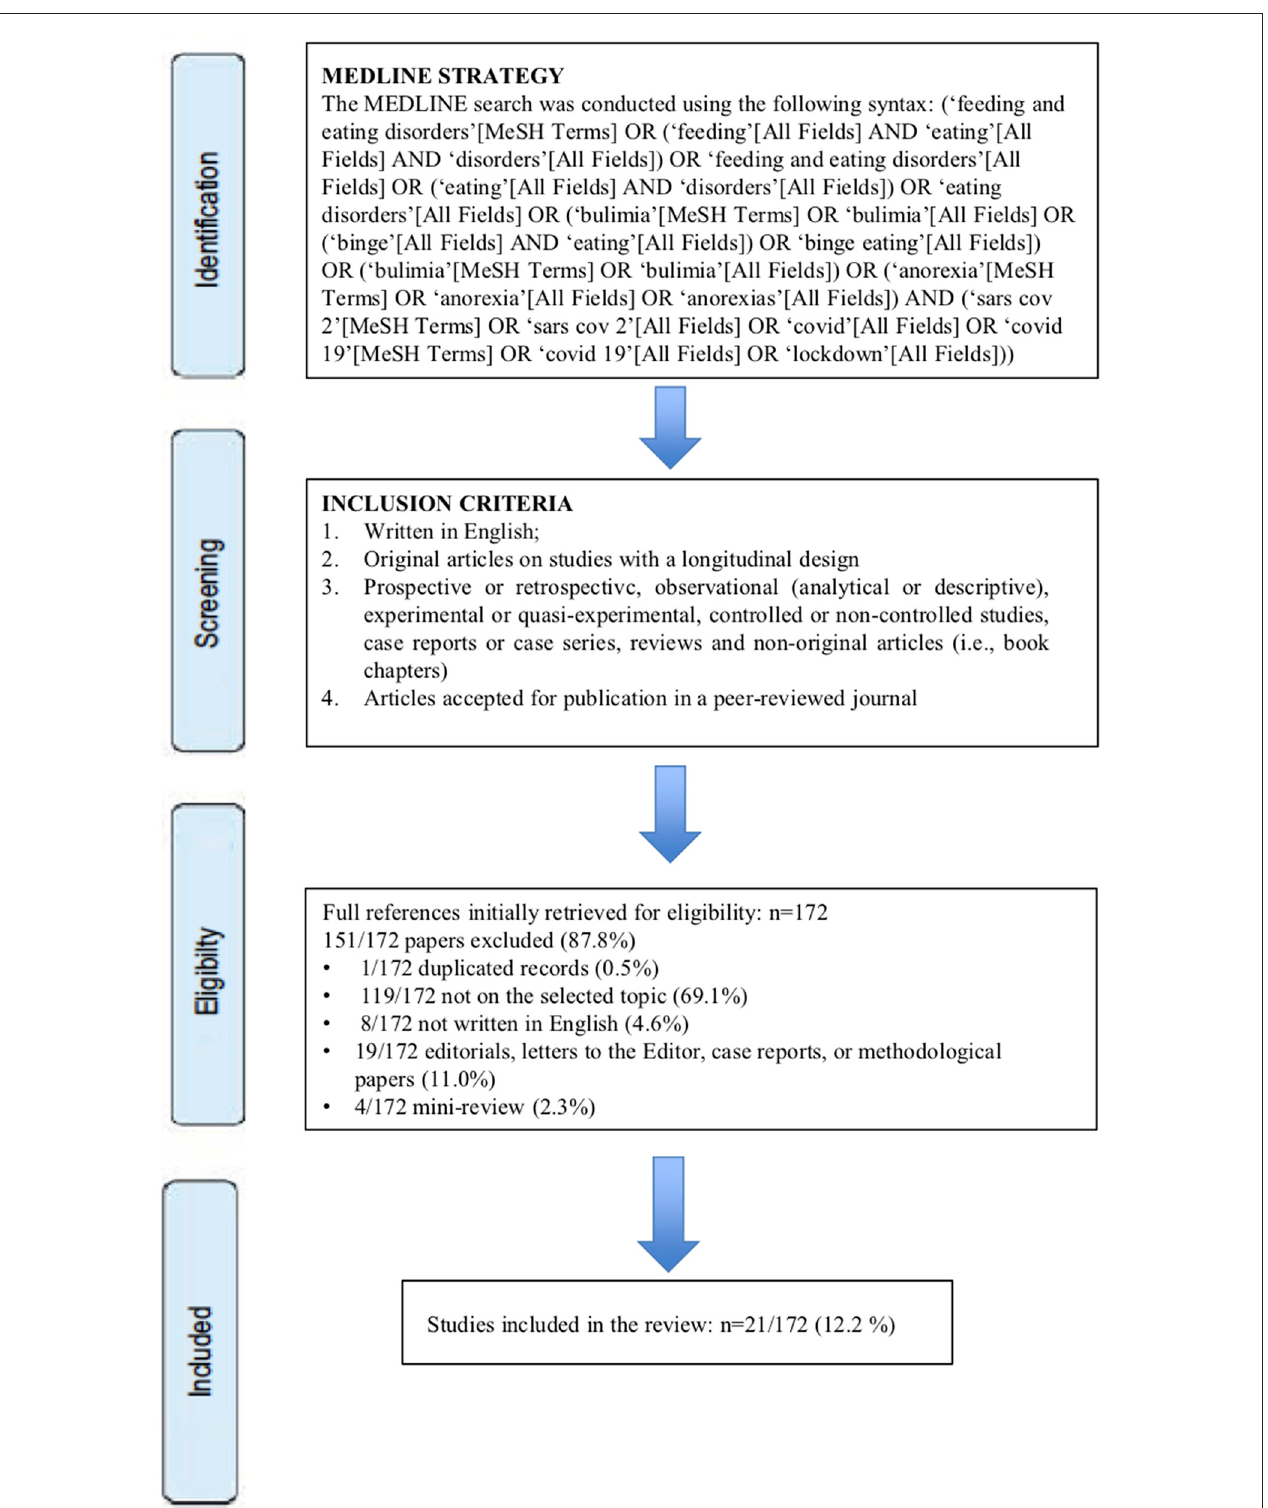
FIGURE 1 | An overview of selection